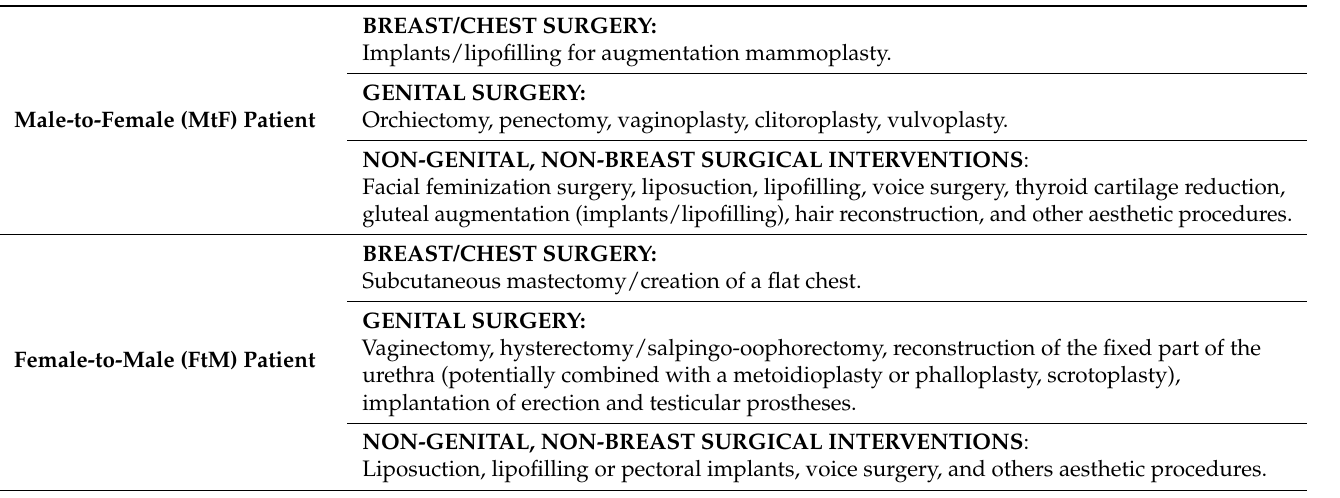
Table 2. Overview of available surgical procedures for the treatment of gender dysphoria